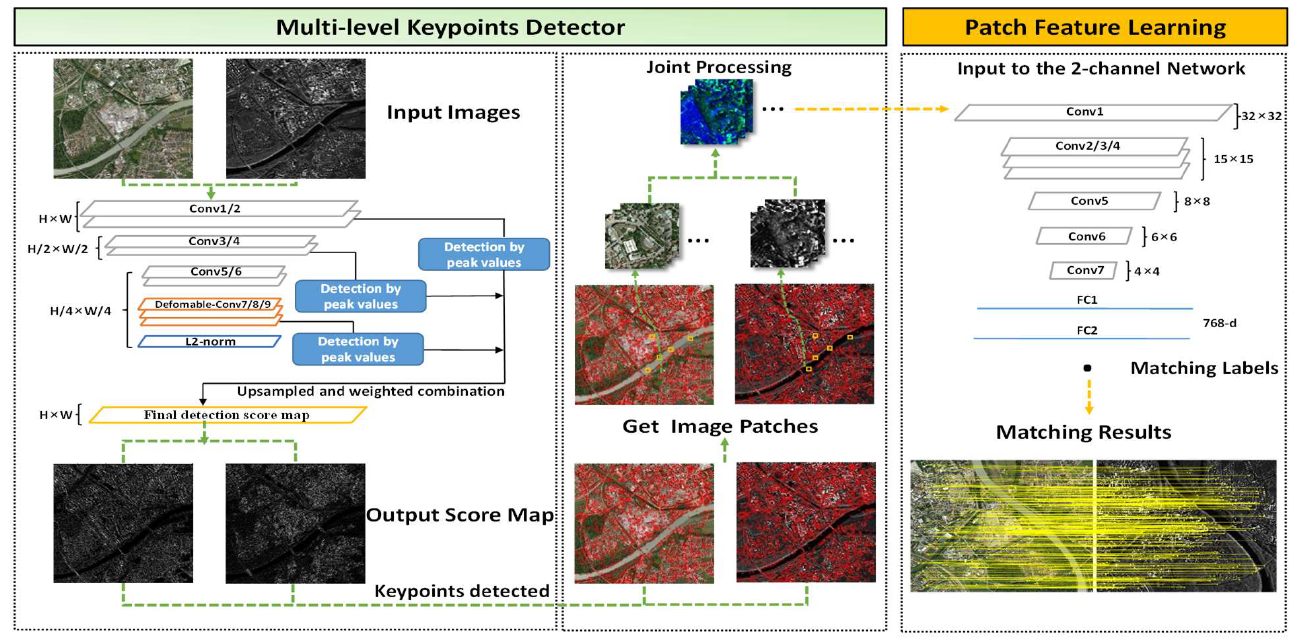
Figure 1. The pipeline of PM-Net. The proposed method has two stages: multi-level keypoints de- tector and patch feature learning. detector and patch feature